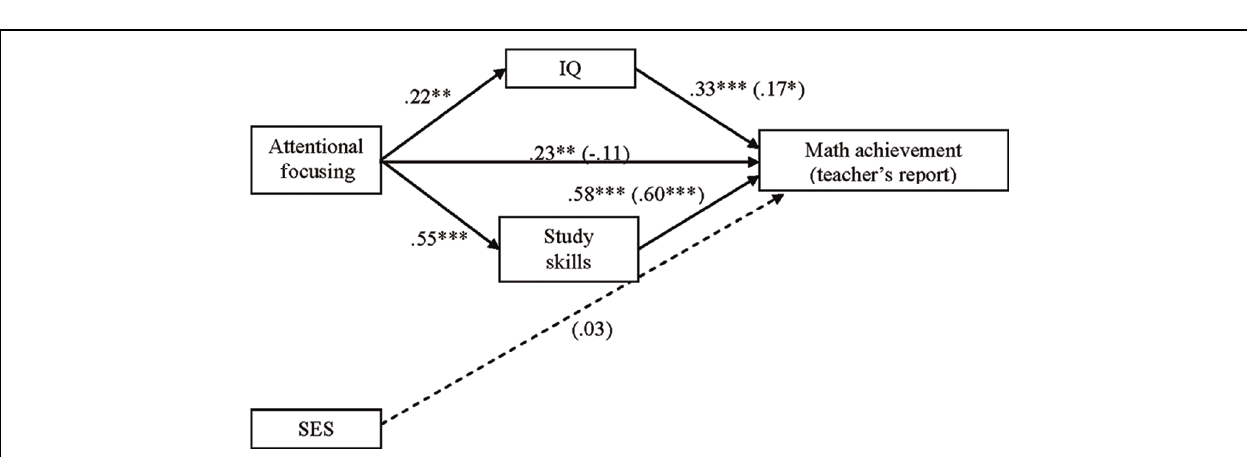
FIGURE 4 | Intellectual-abilities model with IQ and study skills as mediators in the AF and math achievement (teacher’s report) association. Numbers in the figure are beta coefficients ( ˆ β for mediational model are in parentheses). ∗ p < 0.05; ∗∗ p < 0.01; ∗∗∗ p < 0.001.